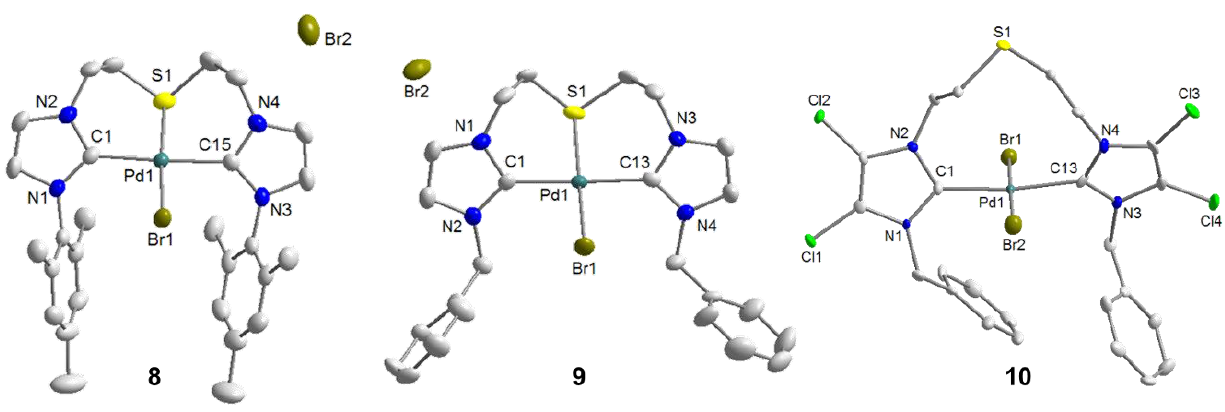
Figure 9. Molecular structures of 8 , 9 and 10